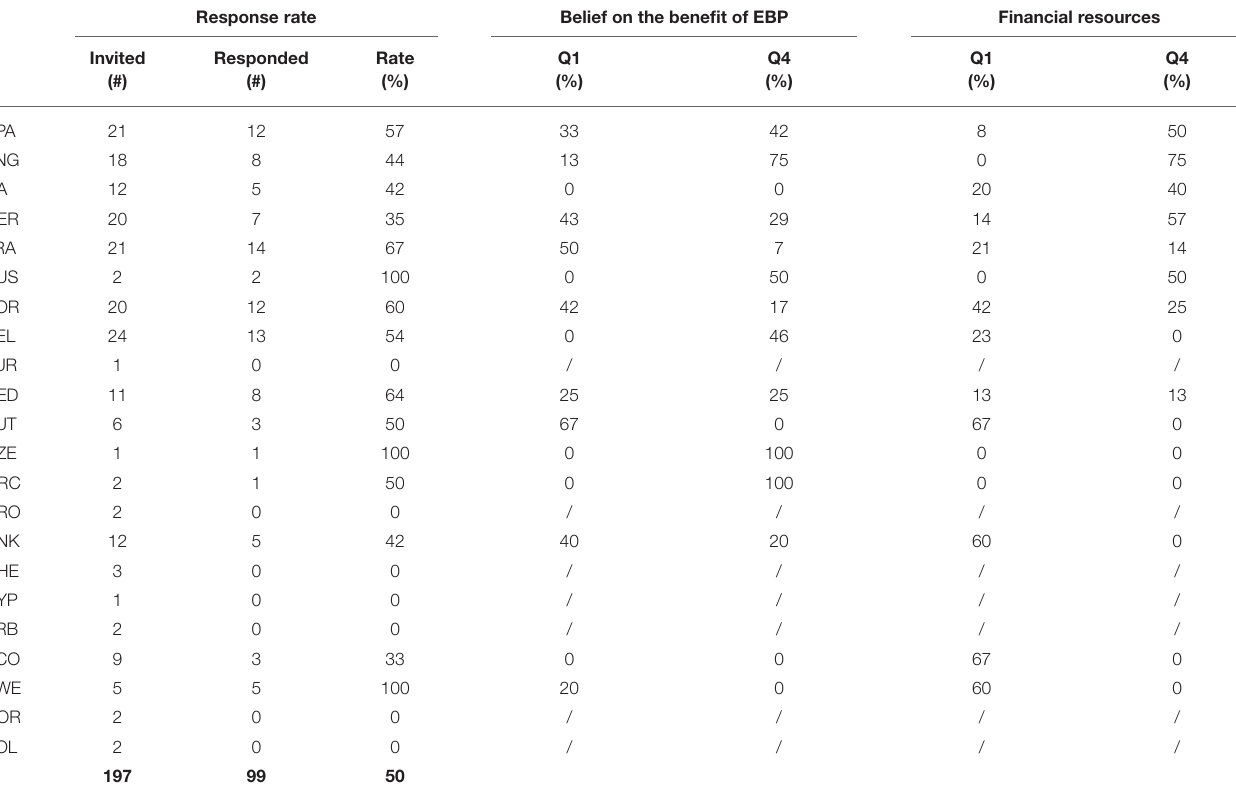
TABLE 1 | Number of clubs invited per federation a and corresponding response rates. Response rate Belief on the benefit of EBP Financial